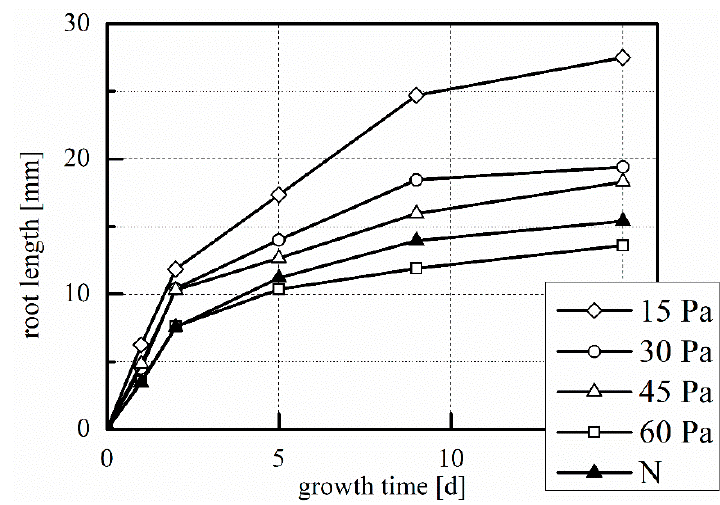
Figure 7. Mean root growth during laboratory germination. 15 Pa, 30 Pa, 45 Pa, 60 Pa: plasma treatments at the indicated working pressure; N: untreated control. Number of replications: n = 4 (of 5 samples each, total 20 samples).